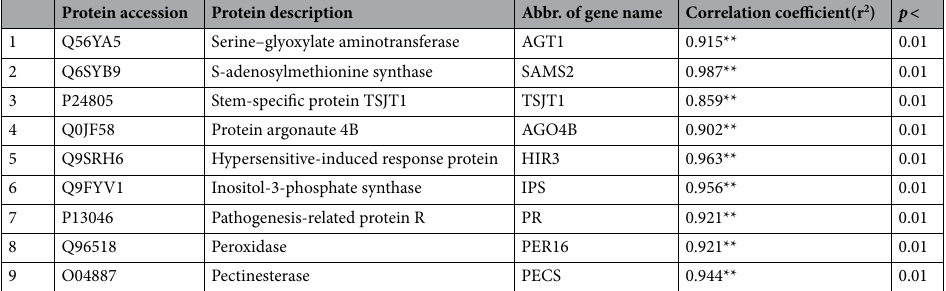
Table 3. The correlation of the proteins expression level quantified by TMT and PRM.